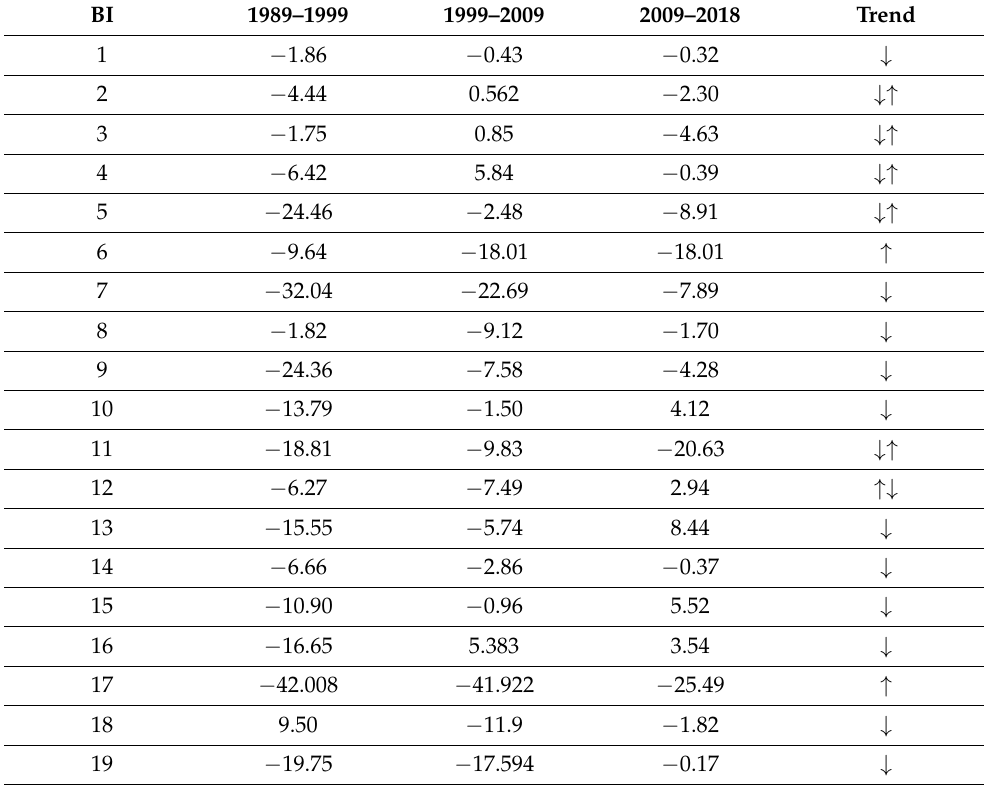
Table 4. End point rate (m/y) for individual time periods. (notes: ↑ represents erosion acceleration; ↓ represents erosion